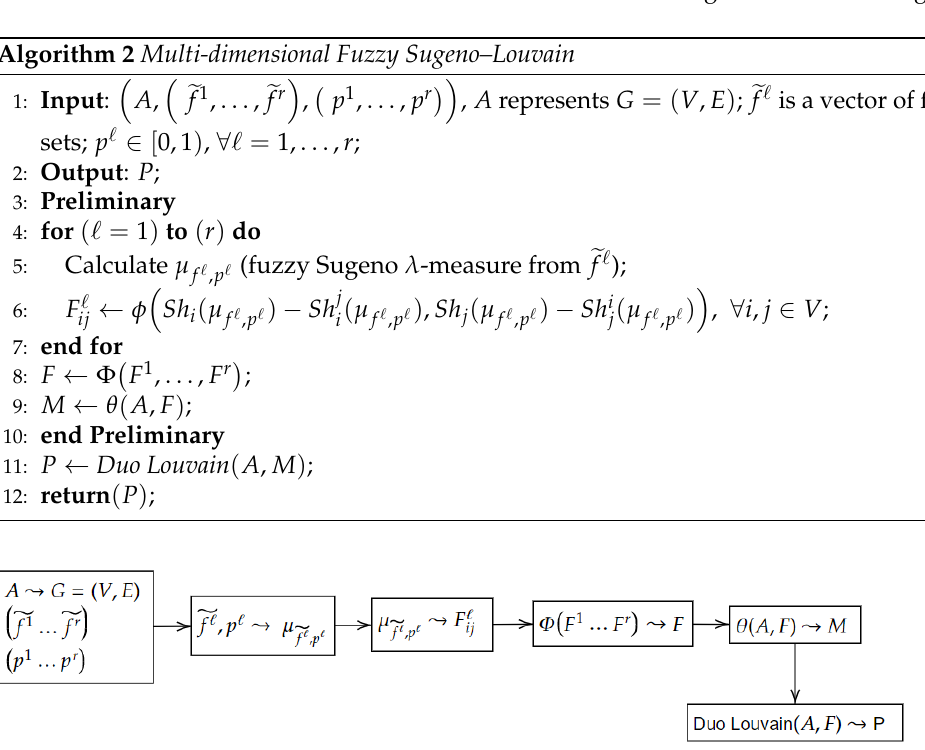
Figure 4. Flowchart of the methodology Multi-dimensional Fuzzy Sugeno–Louvain